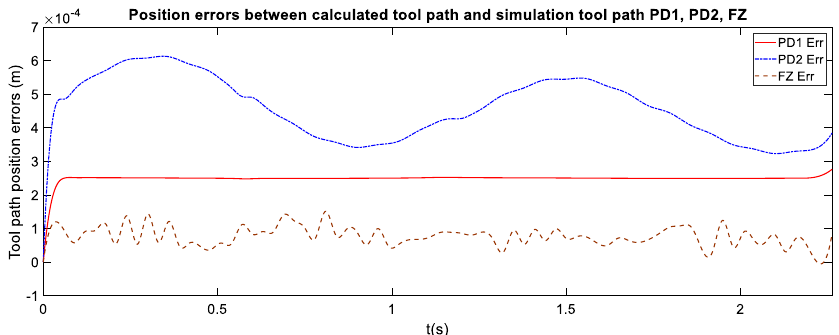
Figure 14. The errors of the cutting trajectory with respect to the set one are the toolpaths of the PD1, PD2, FZ controllers.